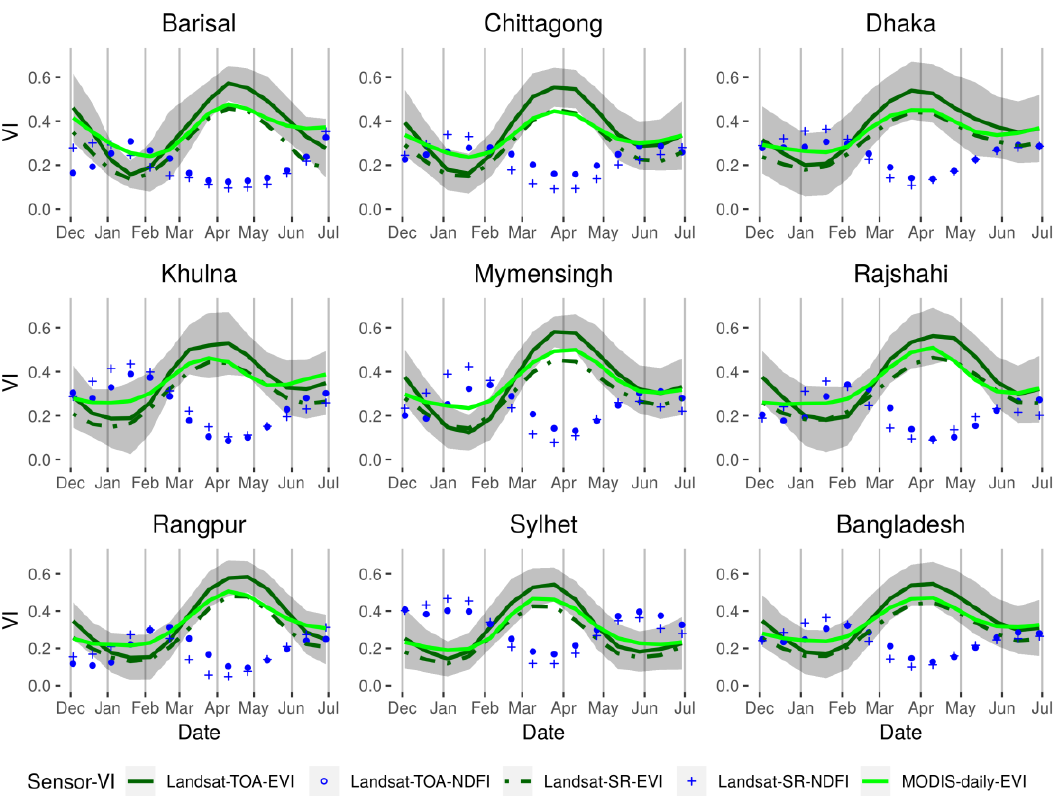
Figure 5. The HTS-VIs model by division in Bangladesh for 2018 (with MODIS comparison). SR: Surface Reflectance; TOA: Top-of-atmosphere.